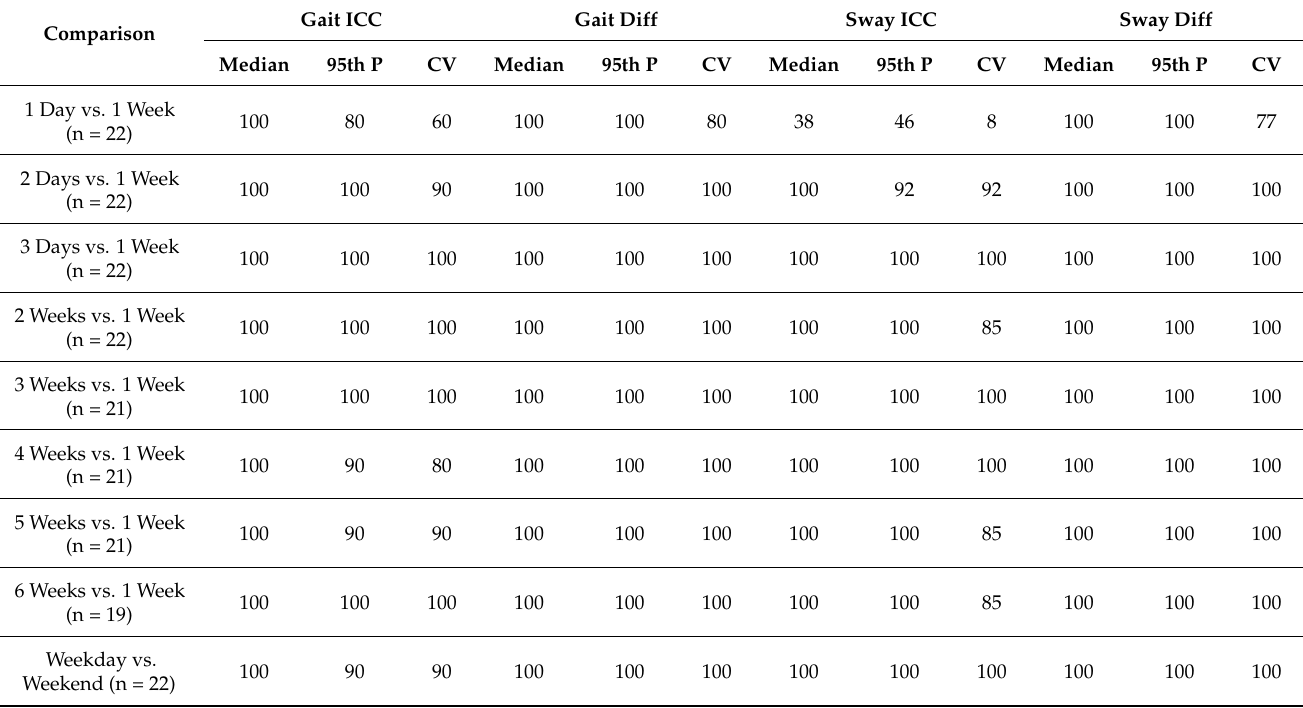
Table 1. Summary of reliability analysis including difference testing and intra-class